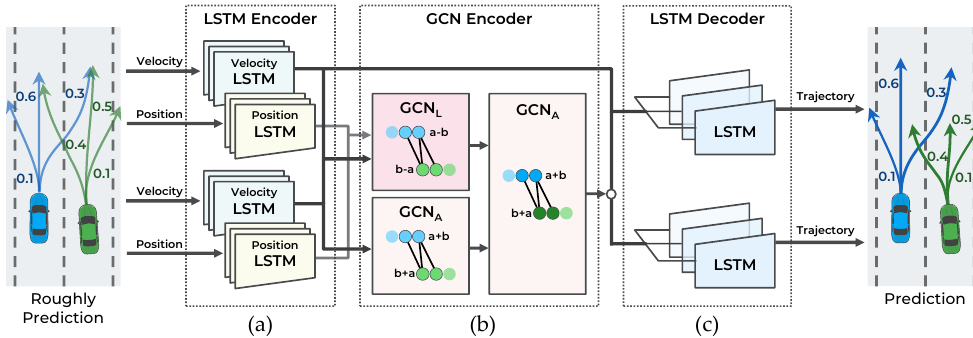
Figure 5. Illustration of interaction-aware trajectory prediction network with three components: ( a ) LSTM encoder, ( b ) GCN encoder, and ( c ) LSTM